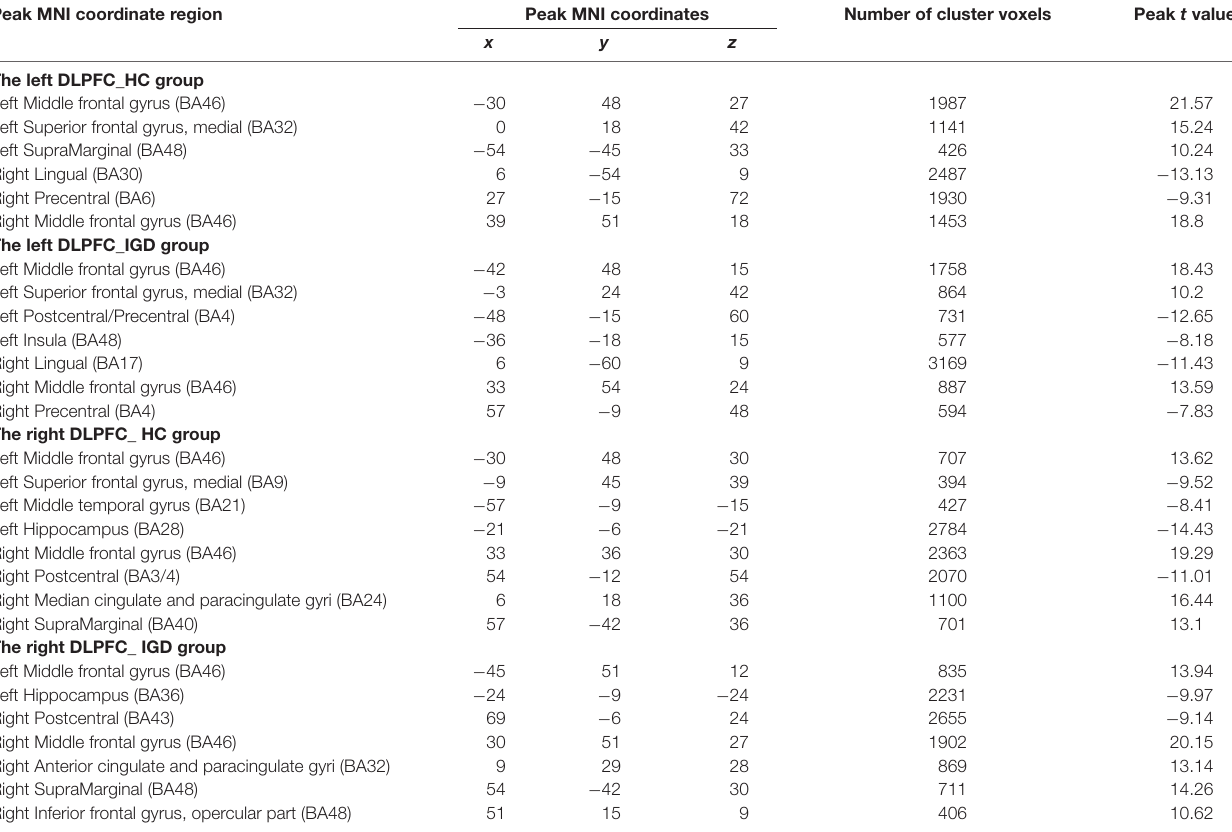
TABLE 2 | Brain connectivity in internet gaming disorder (IGD) group and healthy control (HC) group. Peak MNI coordinate region Peak MNI